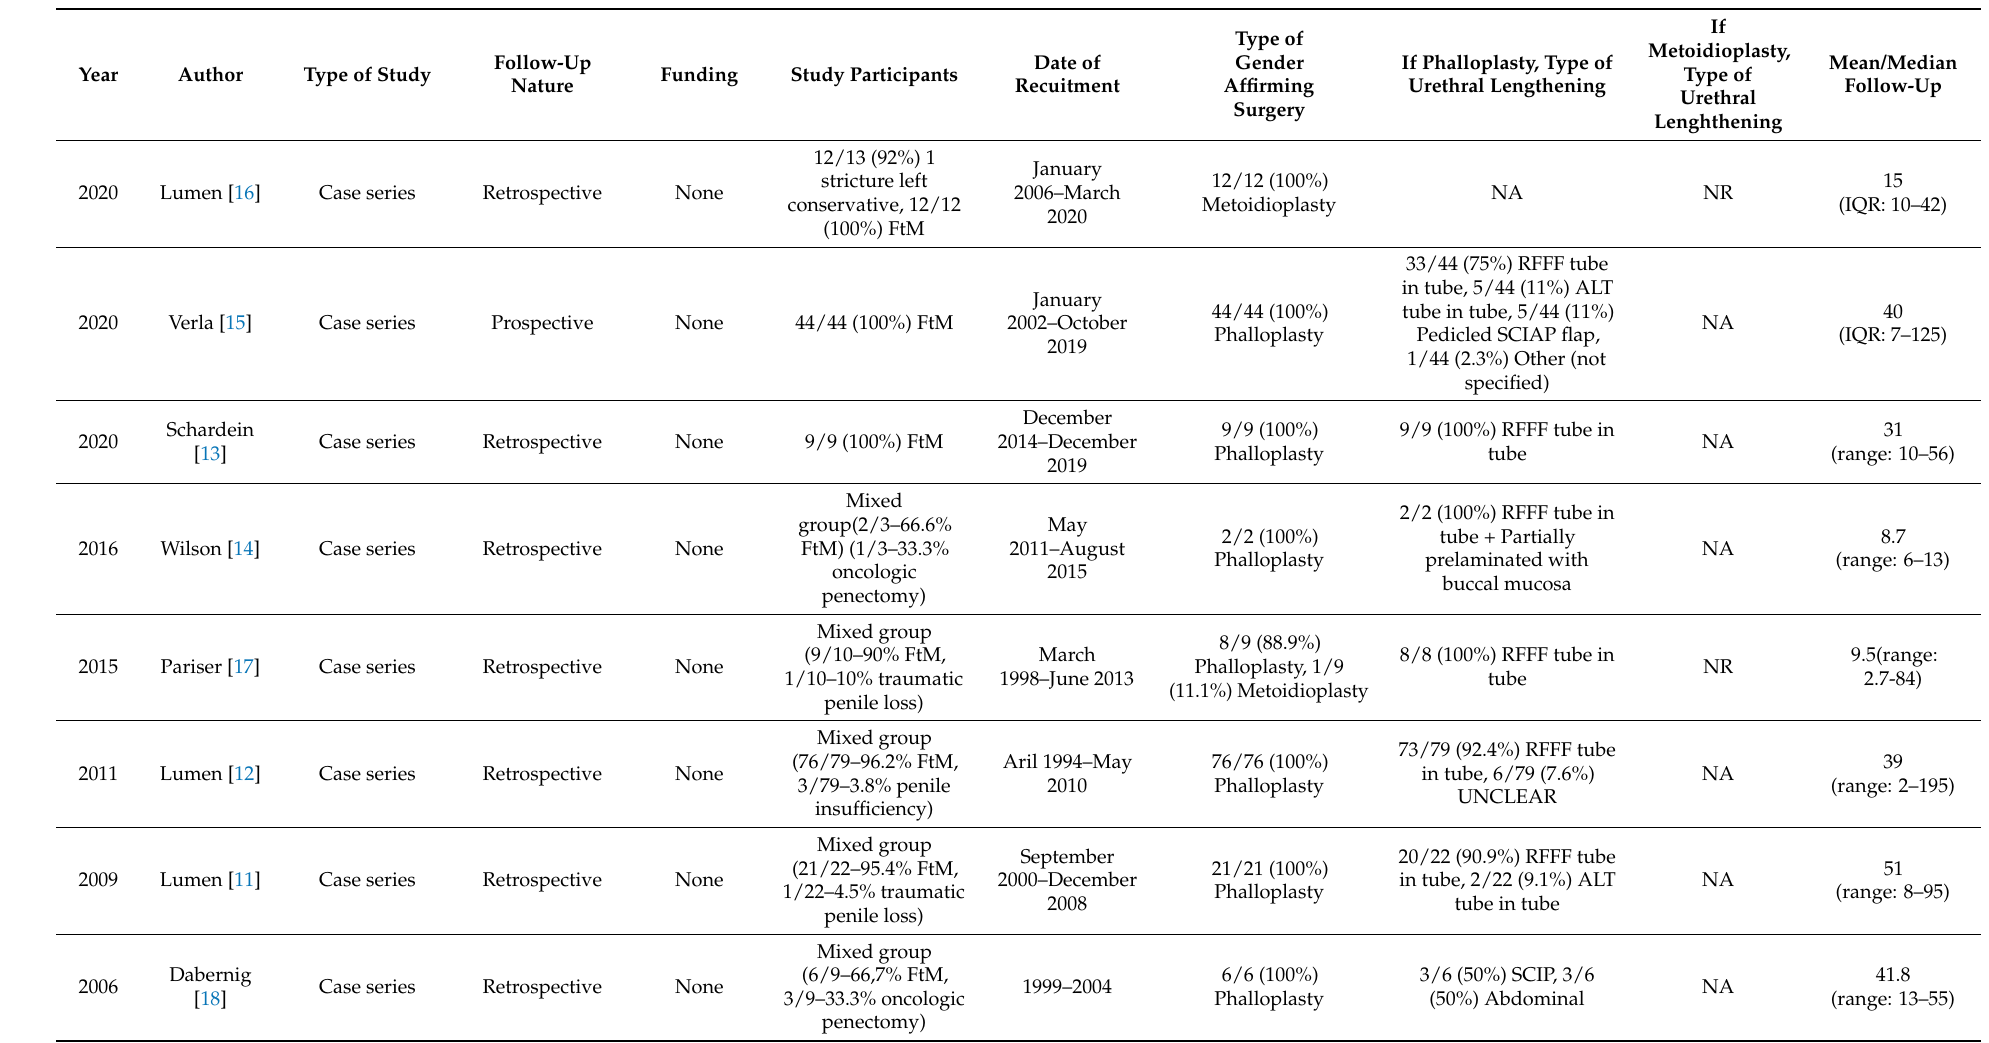
Table 1. Summary characteristics and risk of bias of included studies. FtM (Female to Male), NA (Not Applicable), NR (Not Reported), RFFF (Radial Forearm Free Flap), ALT